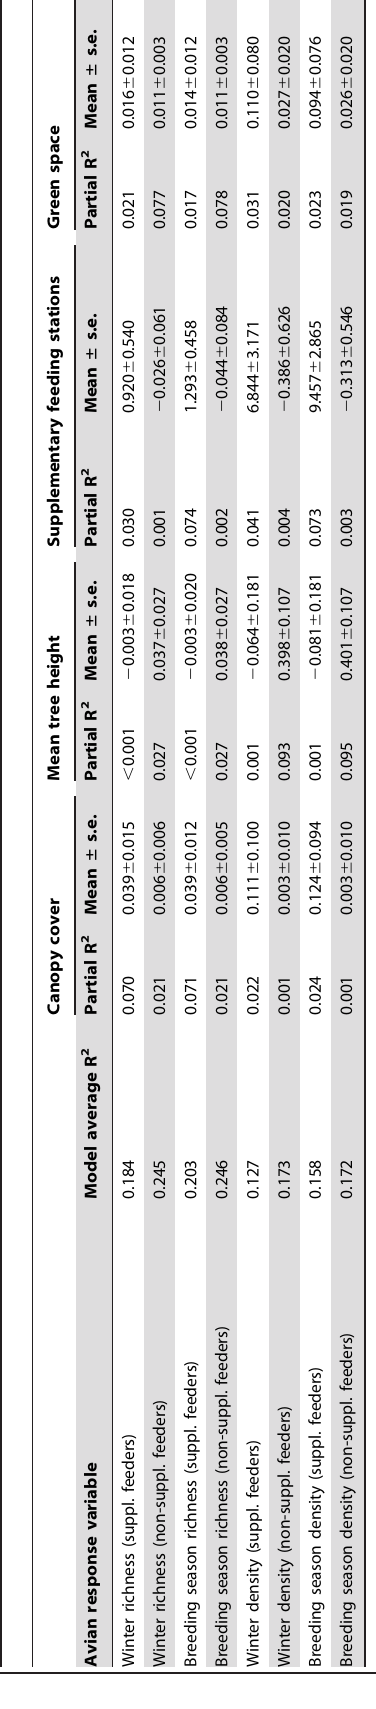
Table S3 Assessments of how taking spatial